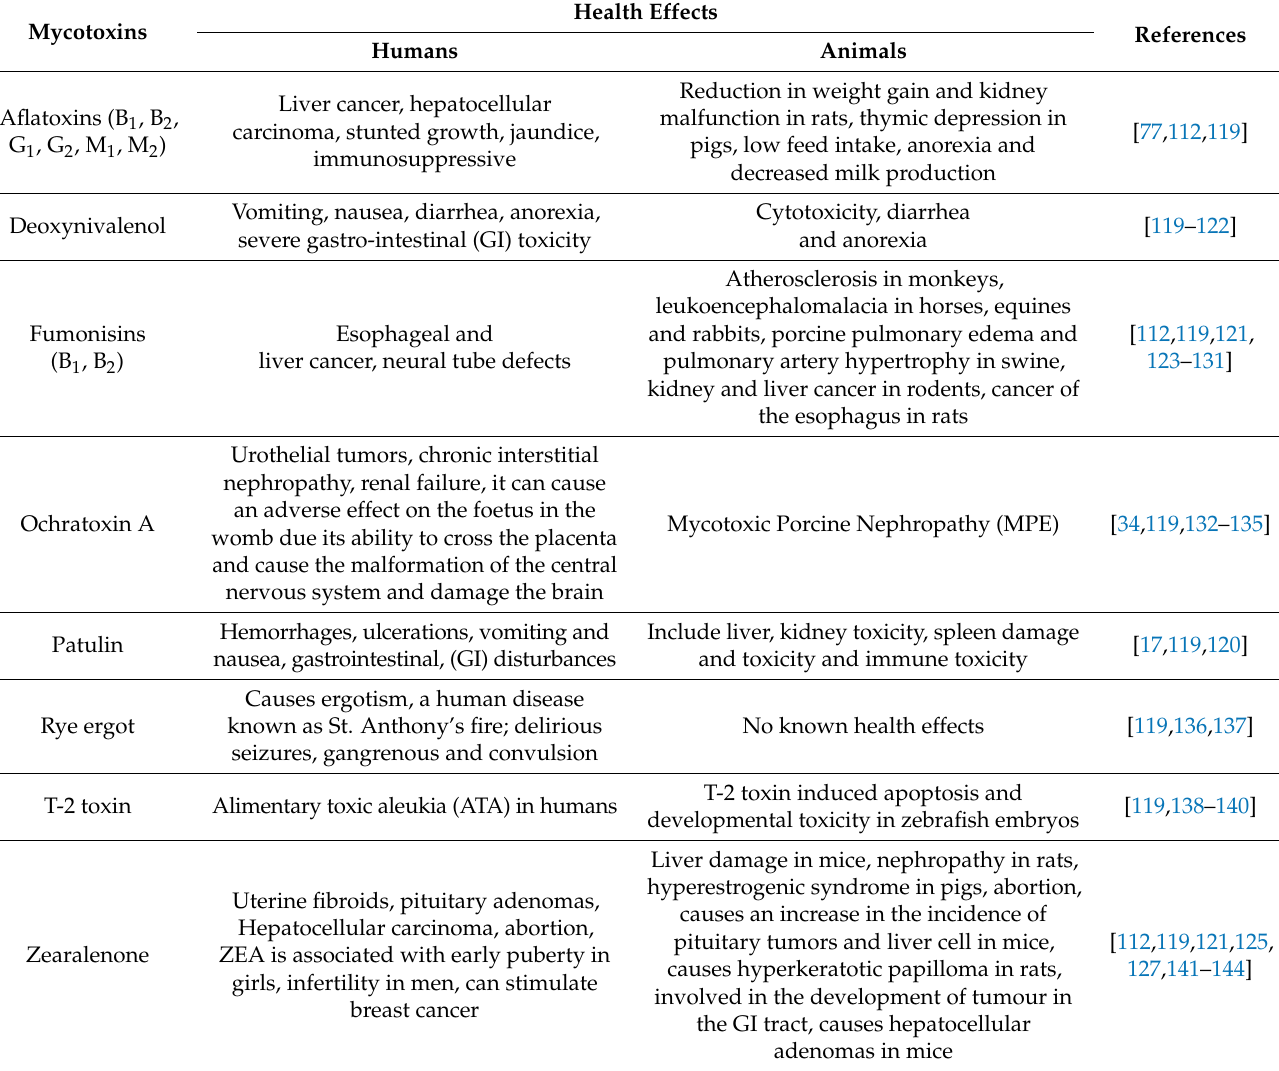
Table 5. Health effects of common mycotoxins on humans and